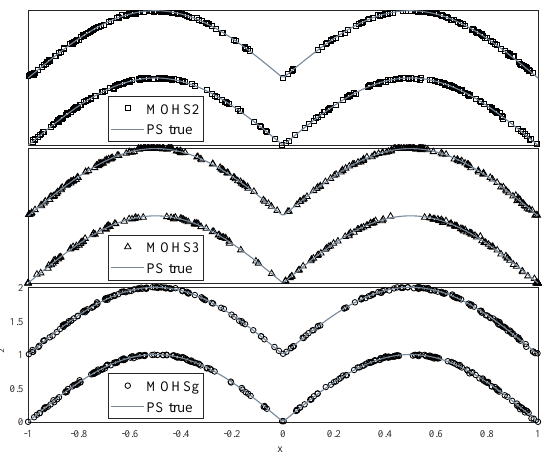
Figure 5. Pareto sets for problem P2.